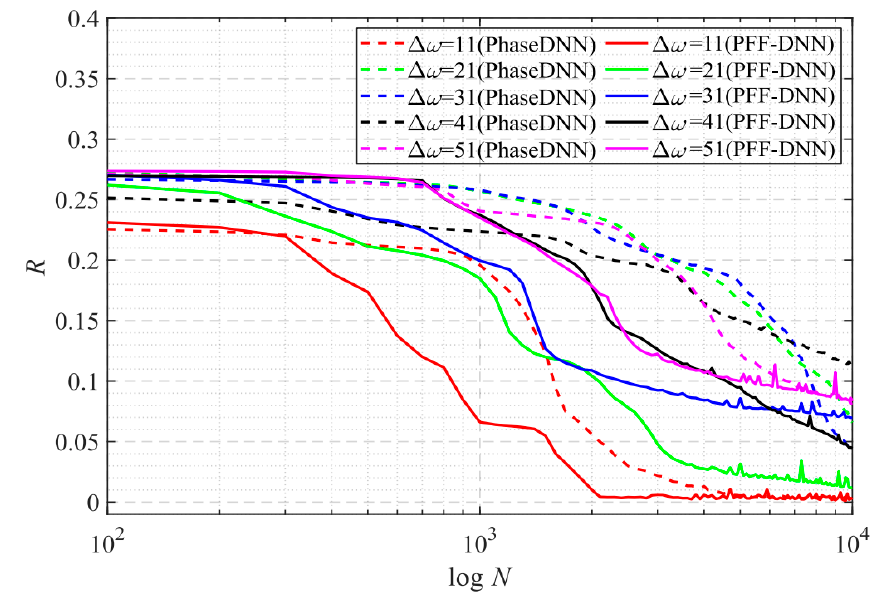
Figure 27. The influence of Δ ω on the convergence process.